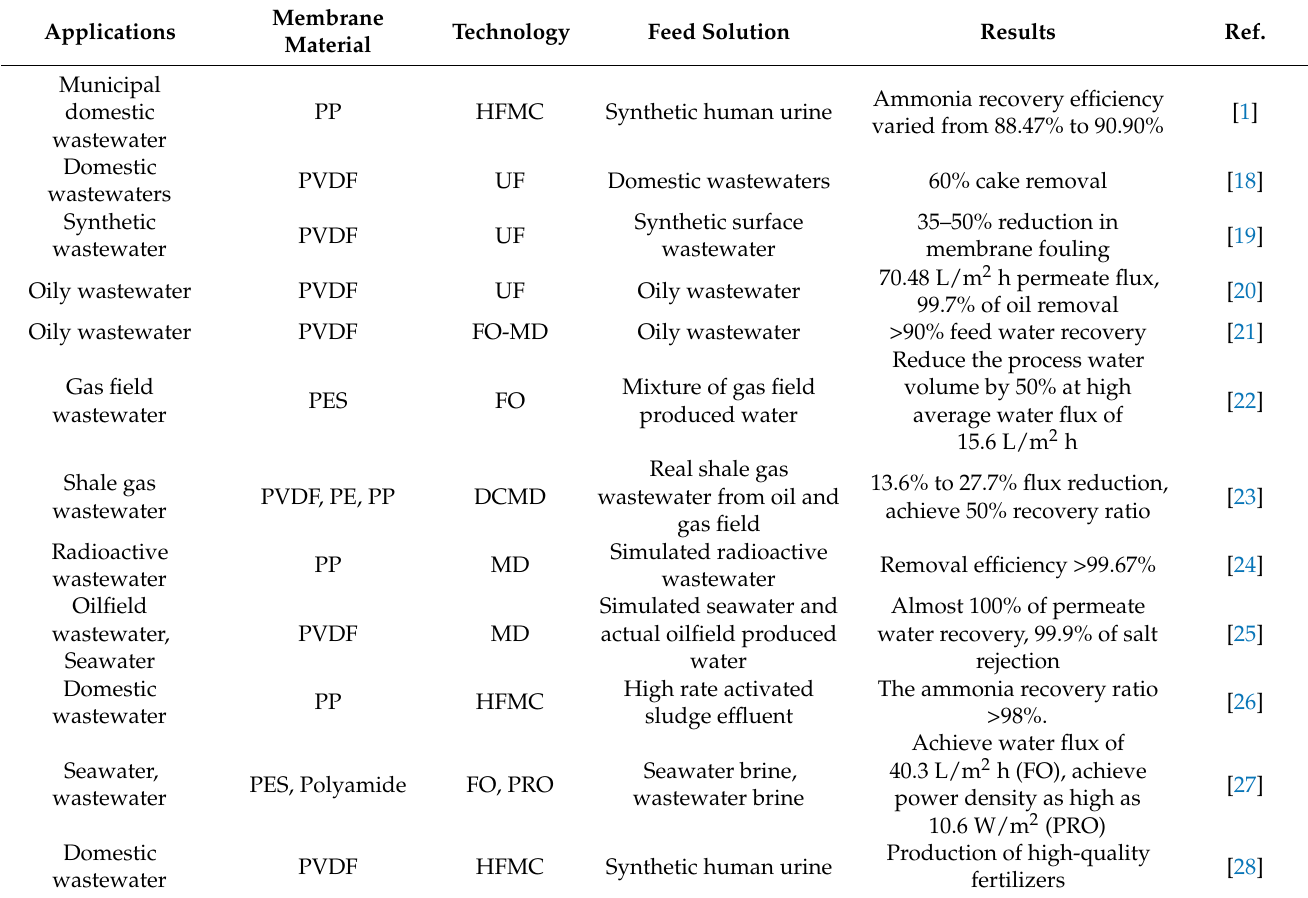
Table 1. Applications of hollow fiber membrane in various wastewater